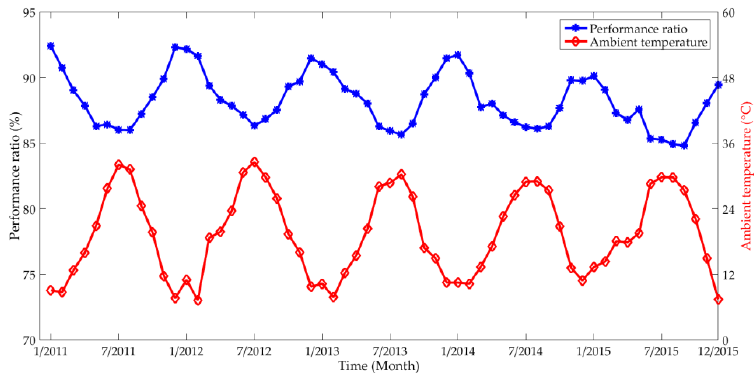
Figure 8. Monthly PR and ambient temperature after data filtering.